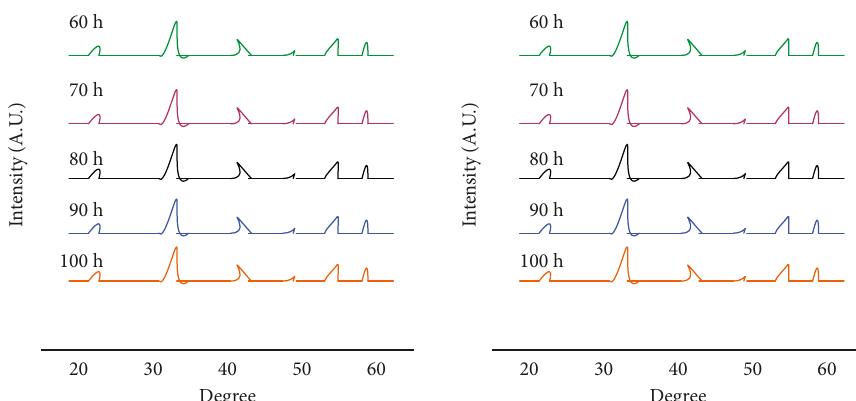
Figure 4: XRD patterns of BaTiO 3 synthesized at different reaction temperatures and different hydrothermal reaction